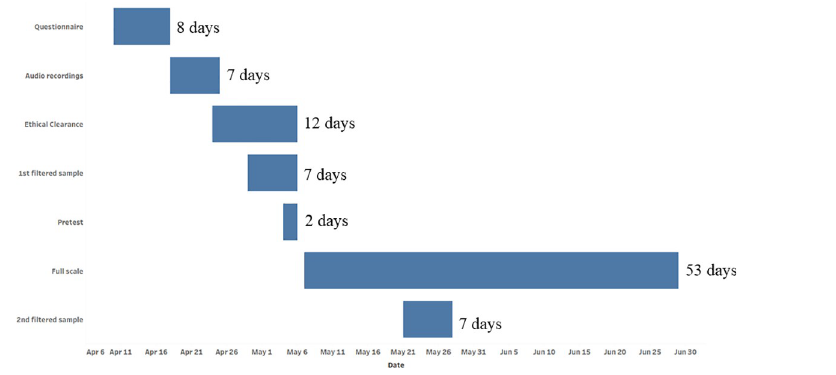
Fig 2. Sri Lanka planning and data collection